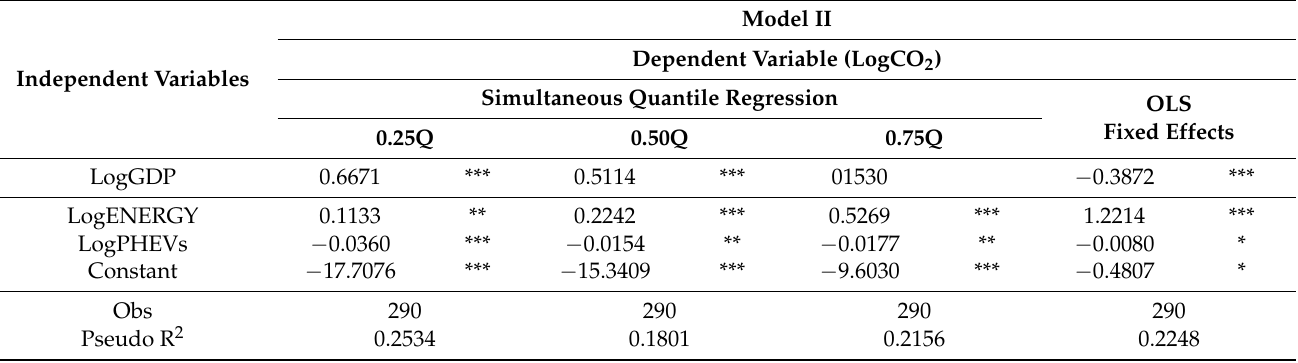
Table 11. Estimation results from simultaneous quantile regression and OLS with fixed effects.